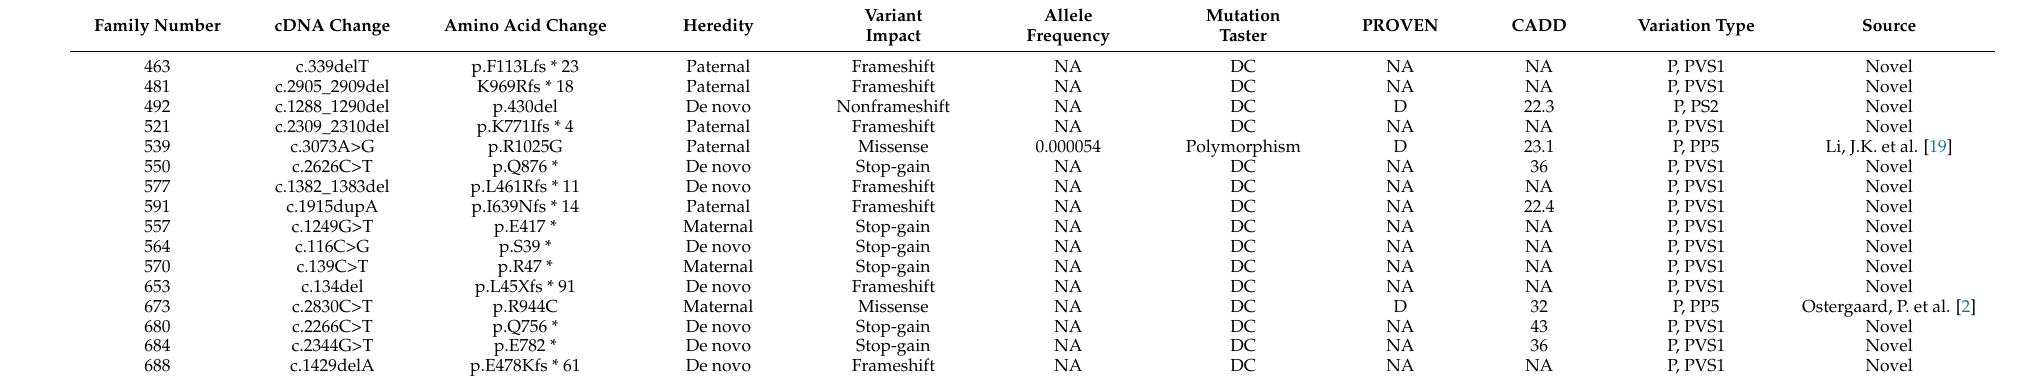
Table 4. Variants identified in KIF11